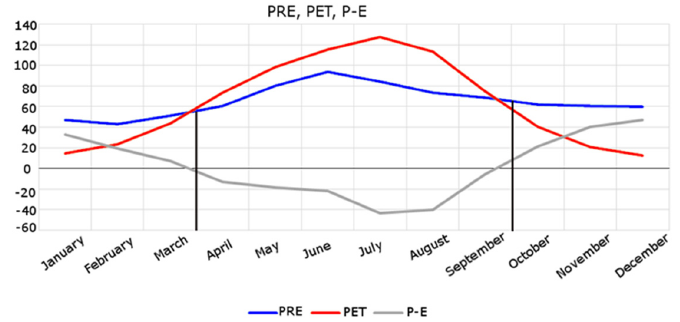
Figure 2. The climatological annual cycle of precipitation (PRE, blue line), potential evapotranspiration (PET, red line) and their difference (P-E, grey line) averaged over the Danube River Basin (DRB) for 1980–2014. Data from Climatic Research Unit (CRU). Scale in mm/day. Vertical red lines indicate the two identified seasons: summer from April to September and winter from October to March.